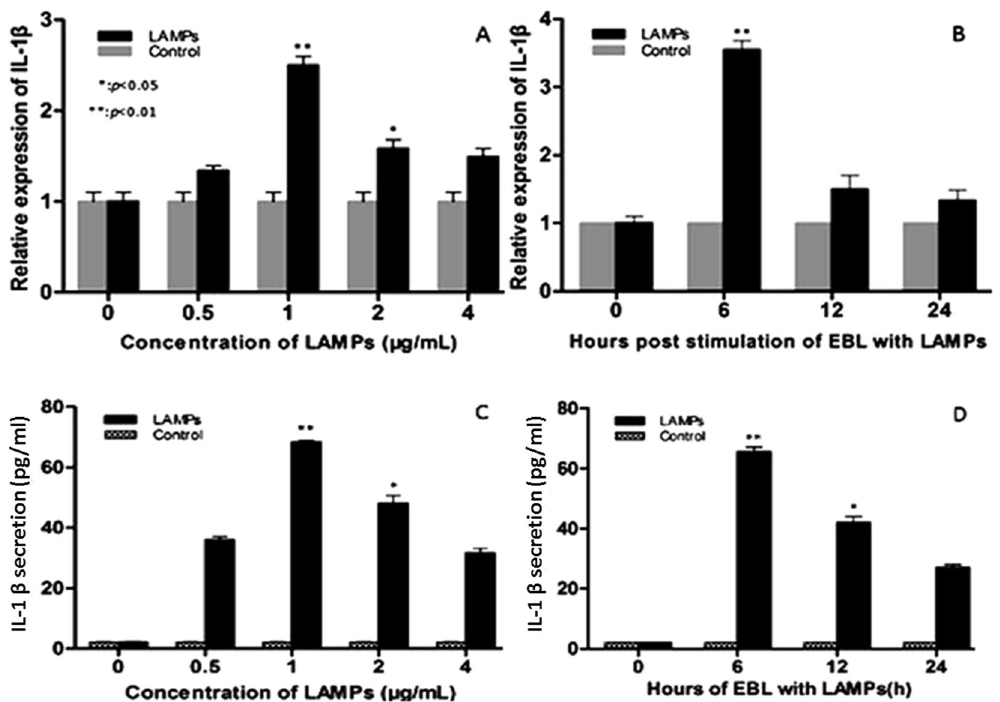
Figure 1. Mmm-derived LAMPs induce IL-1 β expression. ( A and C ) EBL cells were cultured in serum- containing medium and then stimulated with the indicated concentrations of LAMPs for 6 h. Cells and supernatants were respectively harvested and analyzed by real-time PCR and ELISA. ( B and D ) EBL cells were stimulated with 1 μ g/mL Mmm-derived LAMPs for 0, 6, 12, or 24 h (PBS was used as a negative control). The cells and supernatants were respectively harvested and analyzed by real-time PCR and ELISA. Data are presented as the mean and standard deviation of three assays. * p < 0.05 compared with PBS-treated cells. ** p < 0.01 compared with PBS-treated